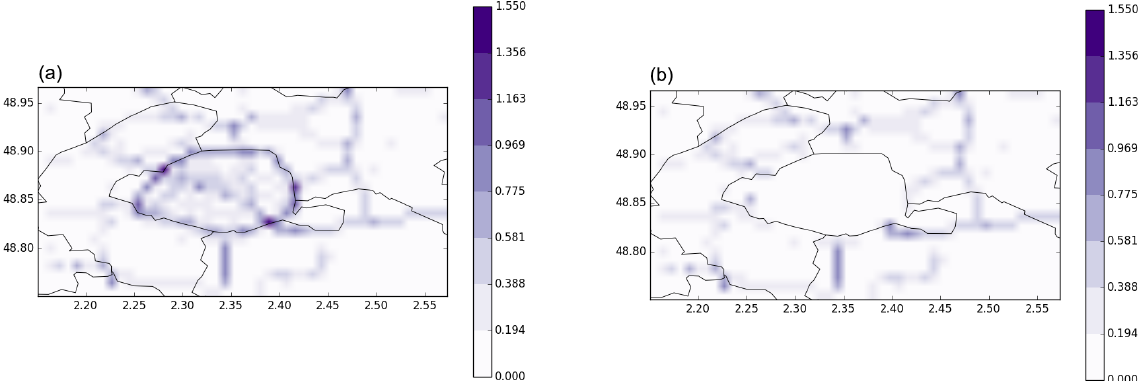
Figure 4. Average over the simulated period of NO 2 anthropogenic emissions (µgs − 1 m − 2 ) used as input for the regional-scale simulations over Paris with Polair3D (a) and as input for the regional-scale module of the multi-scale simulations with SinG (b) .